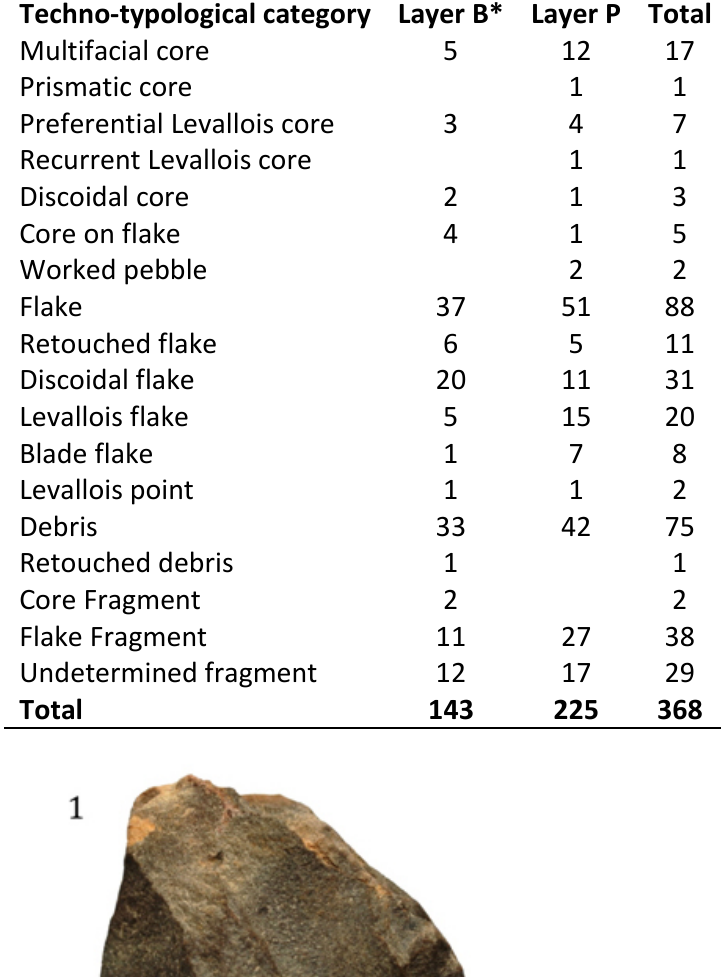
Table 1. Techno-typological lithic categories.